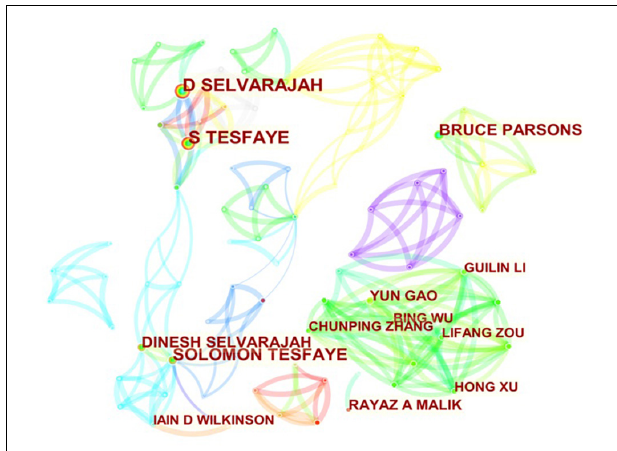
FIGURE 9 | The analysis of authors. Network diagram of influential authors devoted to DPNP research.